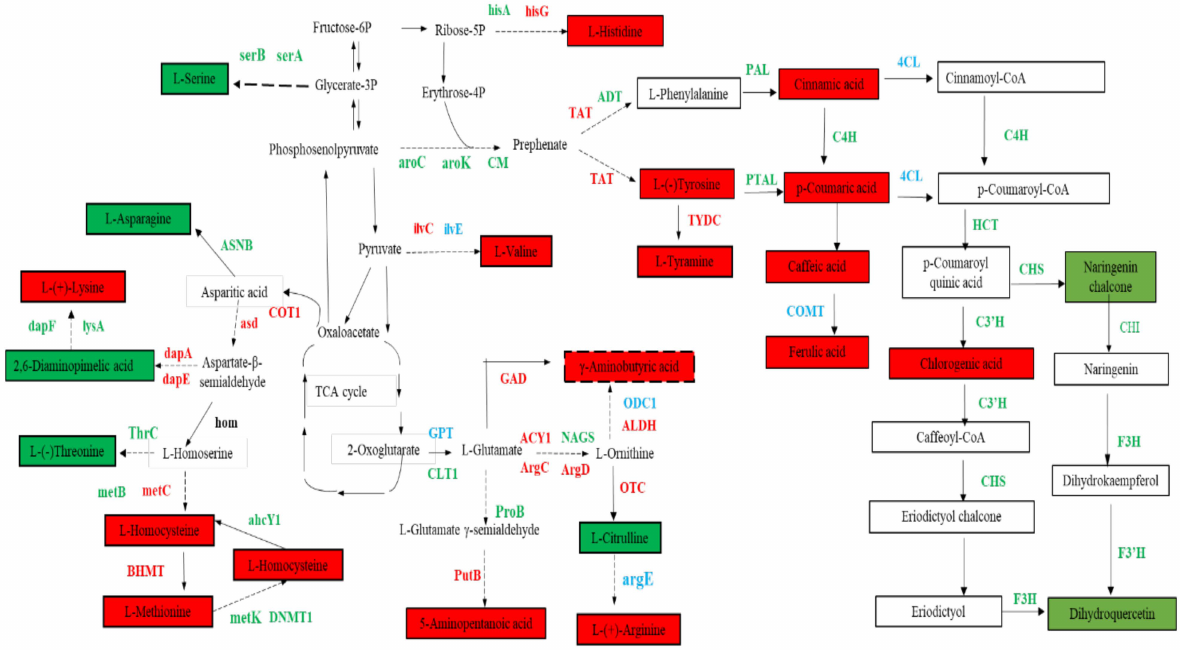
Figure 6. Changes in the characteristic metabolites and DEGs in the synthesis pathway of amino acids, phenolic acids, and flavonol derivatives. Color indicates the change in related substances from 30 DAA to 90 DAA; red indicates increased, green indicates decreased, and blue indicates both increased and